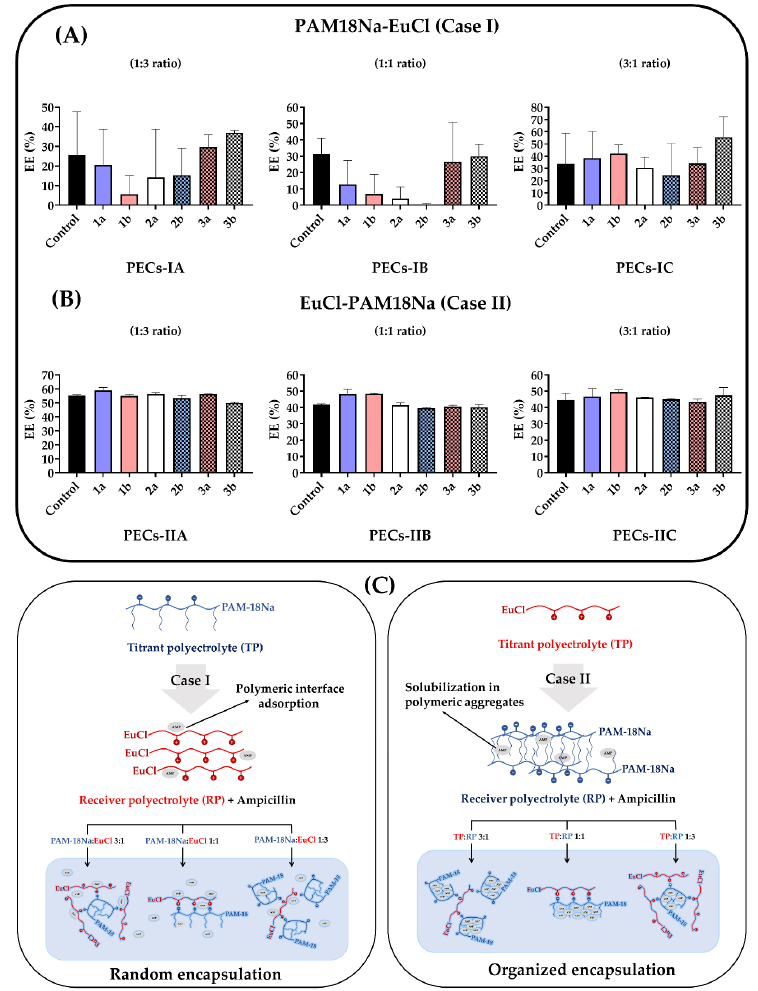
Figure 6. Ampicillin encapsulation efficiency in PECNs. ( A ) EuCl:PAM-18Na system. ( B ) PAM-18Na- EuCl system. ( C ) Schematic of the encapsulation process given during polyelectrolytic complexation. The control corresponds to the amount of ampicillin encapsulated in the polyelectrolyte complexes not subjected to